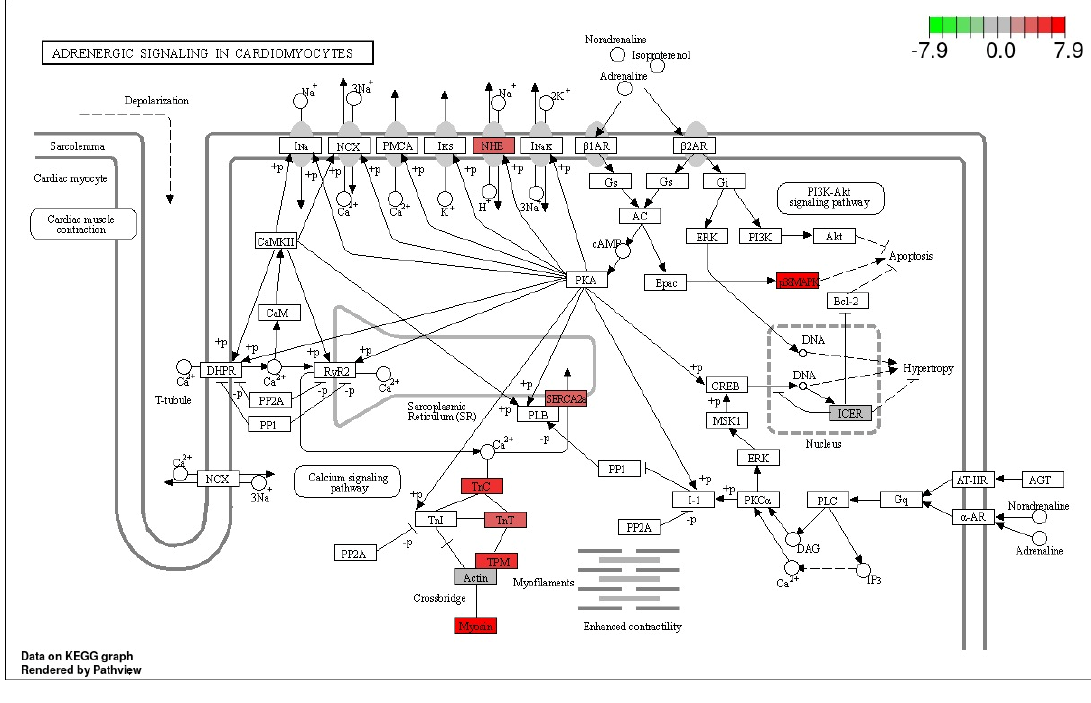
Figure 9. Adrenergic signaling pathway showing the pathway terms that are enriched in ammonia treatment. The color shades refer to the extent of up-regulation.